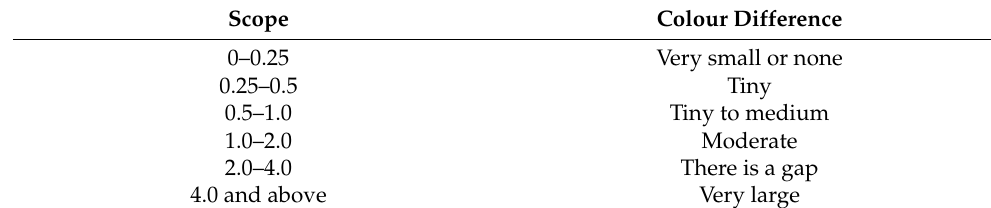
Table 5. Analysis table of colour difference value range.